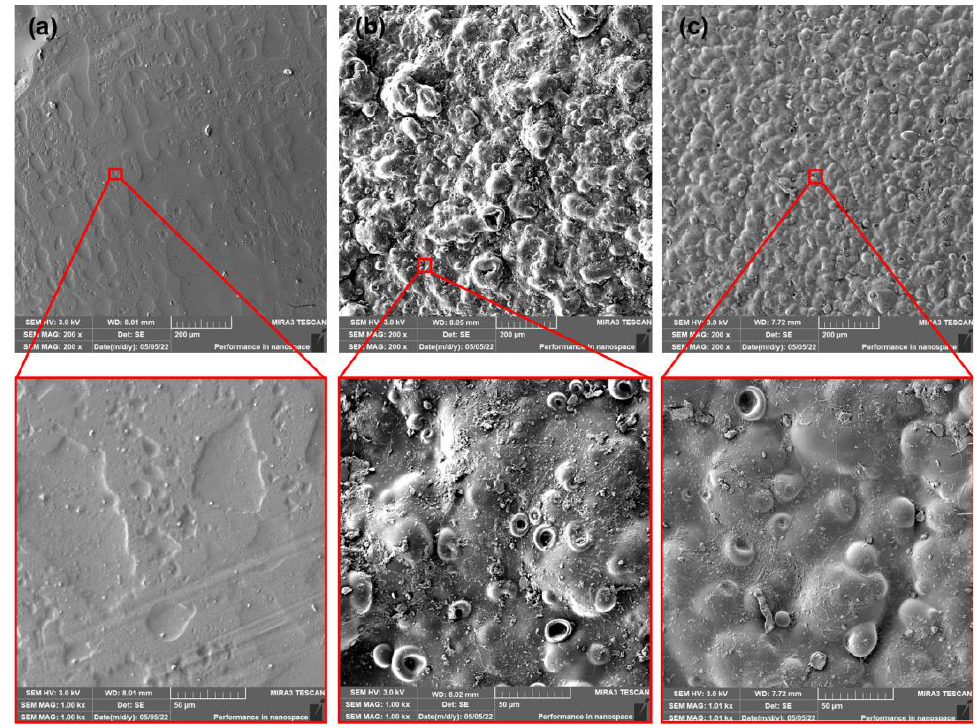
Figure 10. SEM images of as produced PLA/PEG films ( a ) at initial state and after ( b ) 14 days of thermophilic composting, and ( c ) 28 days of thermophilic composting.